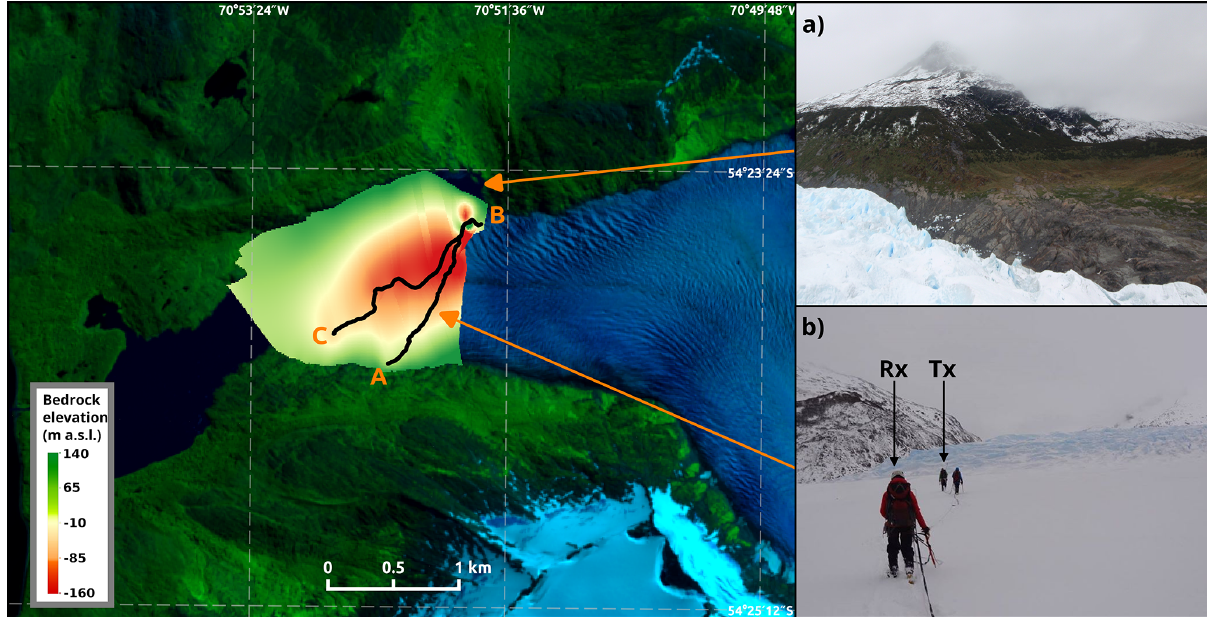
Figure 2. The radar track is shown in black. The coloured area depicts the interpolation of the bedrock elevation using the GPR data and surface data (SRTM, LP DACC NASA version 3) as a reference, using a triangulated irregular network (TIN) grid. A, B, and C indicate the respective positions in Fig. 3. The upper frame (a) shows a photo taken during the GPR measurement from B towards the ice-dammed lagoon (north side). The lower frame (b) shows the team performing the measurements from A to B. Tx and Rx are the transmitter and receiver carriers